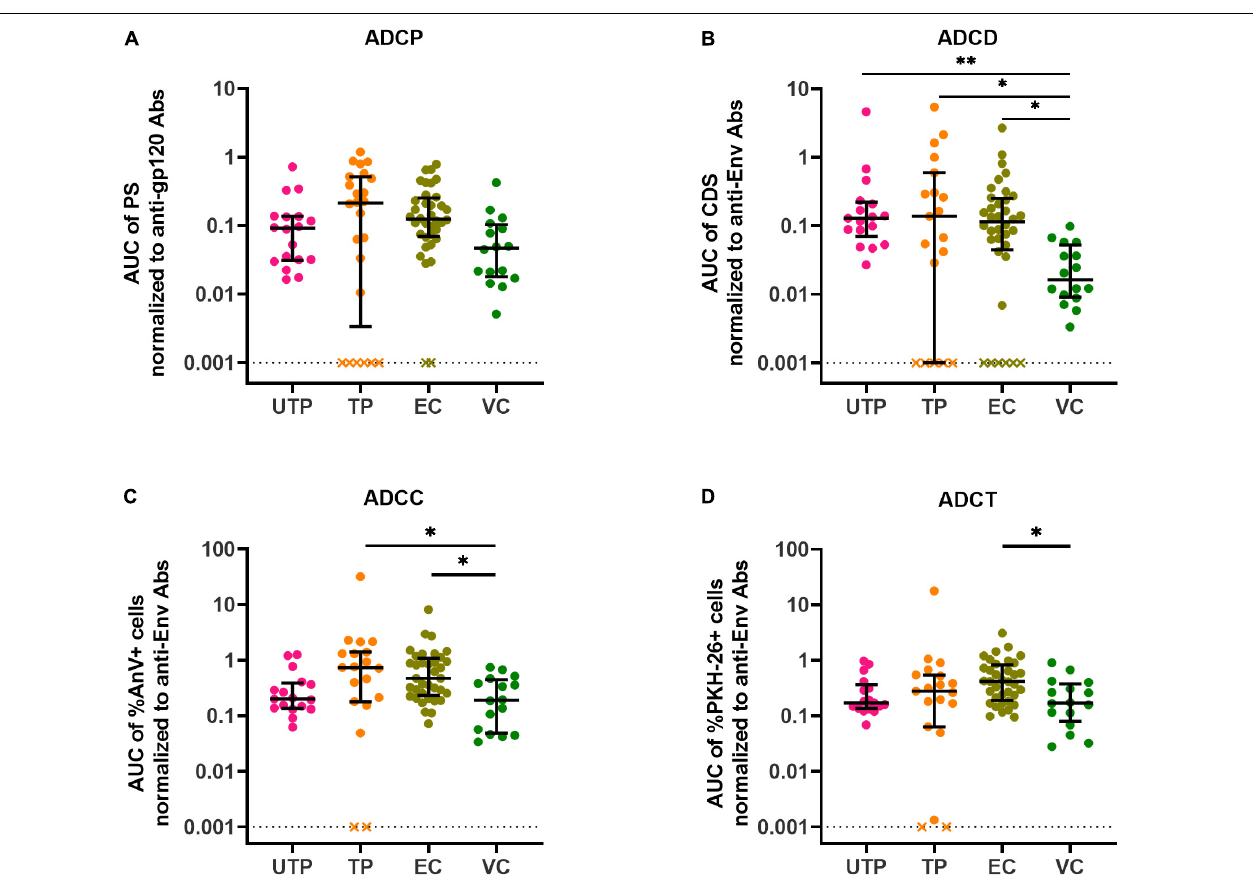
FIGURE 4 | AD function results normalized to input anti-gp120/Env-specific Ab concentrations present in HIV + plasma samples. (A) ADCP functional results were normalized to anti-gp120-specific Ab concentrations in HIV + plasma quantified using the PBE assay (B) ADCD, (C) ADCC, and (D) ADCT functional results were normalized to anti-Env Ab concentrations in HIV + plasma quantified by binding to siCEM cells. Each point represents a single subject. Lines and error bars though each data set represent medians and IQRs. Data from 18 UTPs, 24 TPs, 37 ECs, and 16 VC are used to prepare these four panels. Kruskal-Wallis tests with Dunn’s multiple comparisons post test were used to assess the significance of between-group differences. ∗ p < 0.05, ∗∗ p < 0.01. All results shown were background subtracted and are relative to the concentrations of an internal HIVIG positive control tested at the same time as test samples. “x” symbols represent negative values after background correction. AUC, partial area under the curve; PS, phagocytic score; CDS, complement deposition score; %AnV + cells, frequency of Annexin V + siCEM cells; %PKH-26 + cells, frequency of PKH-26 +